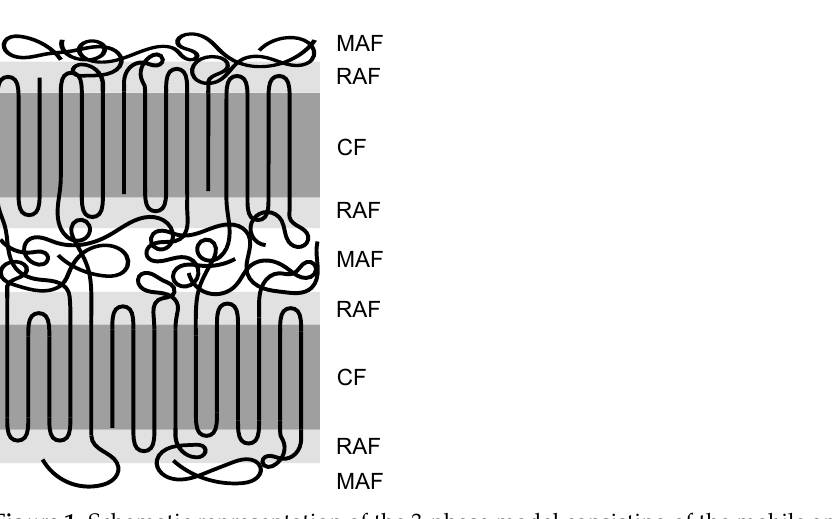
Figure 1. Schematic representation of the 3-phase model consisting of the mobile amorphous frac- tion (MAF), rigid amorphous fraction (RAF), and crystalline fraction